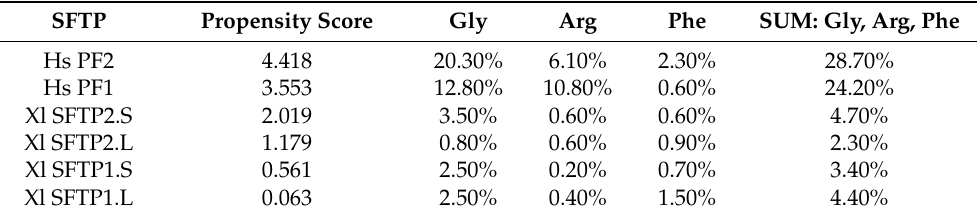
Table 3. catGRANULE overall protein propensity score, and Arg, Gly, and Phe occurrence for